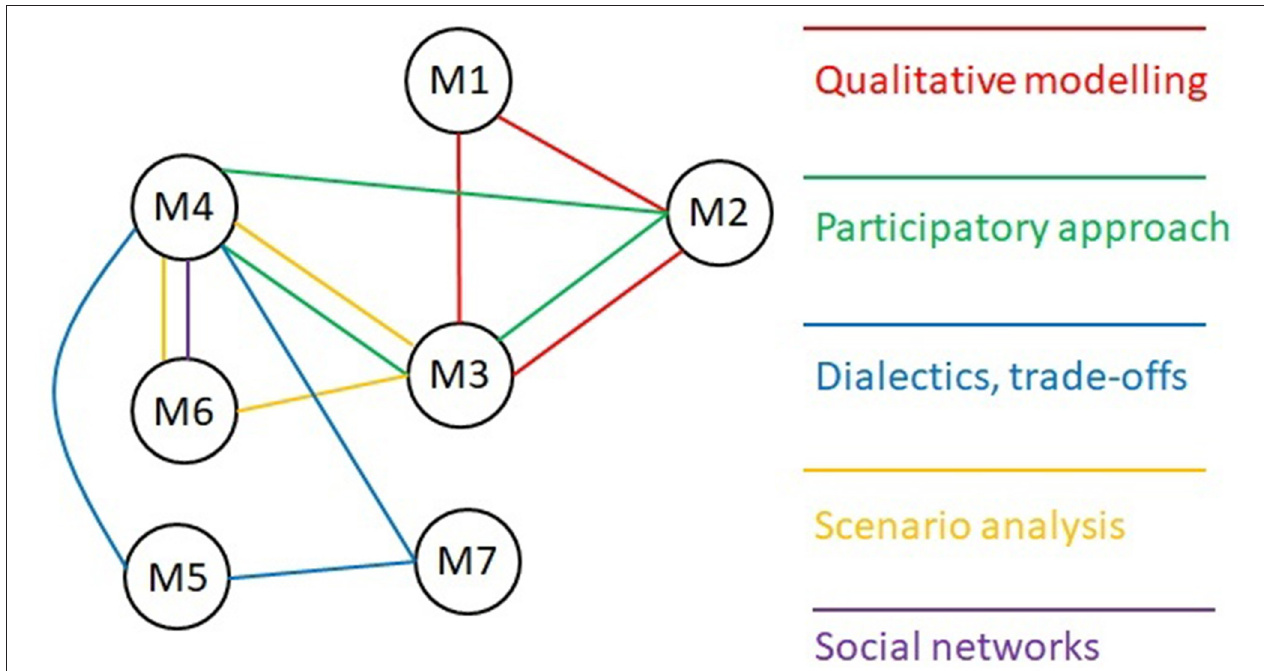
FIGURE 1 | Topical network (left) built around the elements of the socio-ecological research background (in color, on the right) as the contributions forming this essay share them. Directed qualitative links connect any two contributions whenever they share one or more of these elements. Only direct connections are considered. Keys Mn identify the articles comprised in this Research Topic, as explained in the